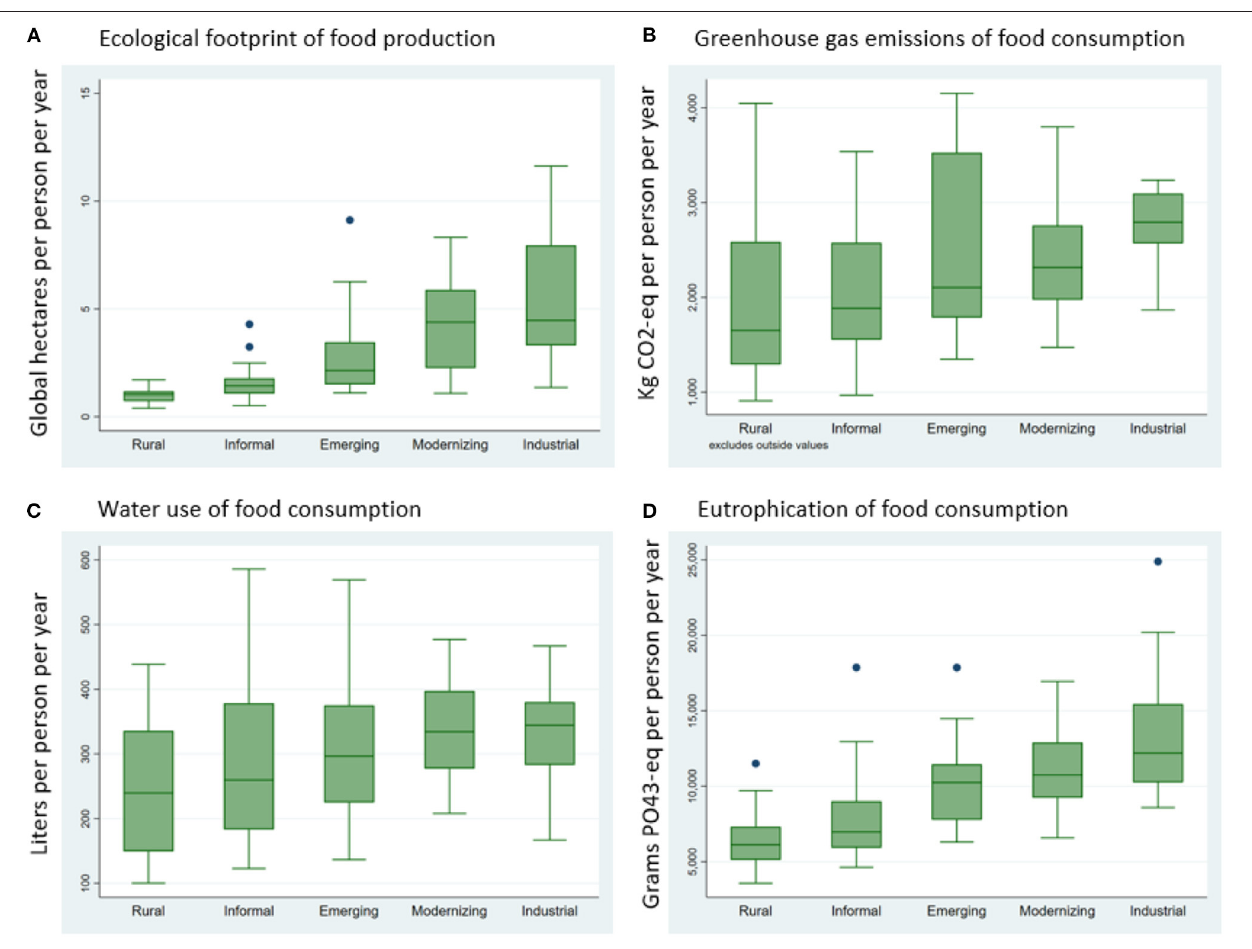
FIGURE 6 | Comparison of environmental outcomes across the food system